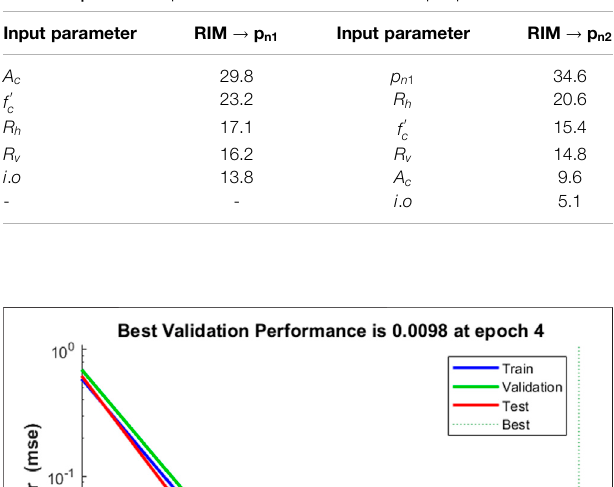
TABLE 7 | Relative importance measurements for the input parameters.